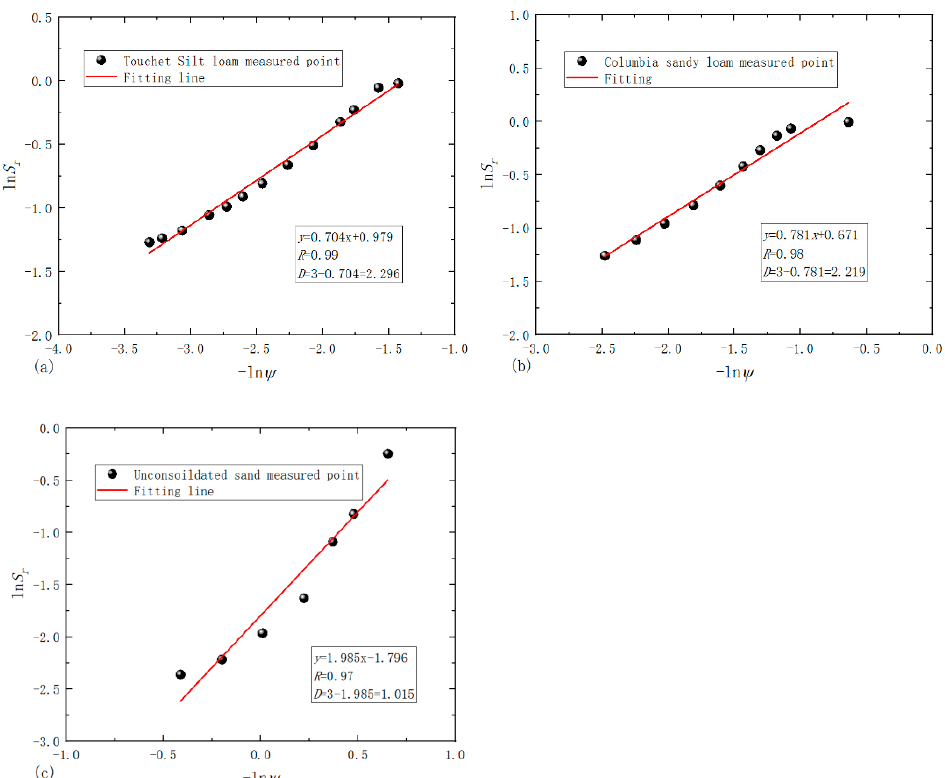
Figure 2. F itting to obtain the fractal dimension of three soil types: ( a ) Touchet Silt loam; ( b ) c ) unconsoildated Columbia sandy loam; ( c ) unconsoildated sand. sandy loam; (